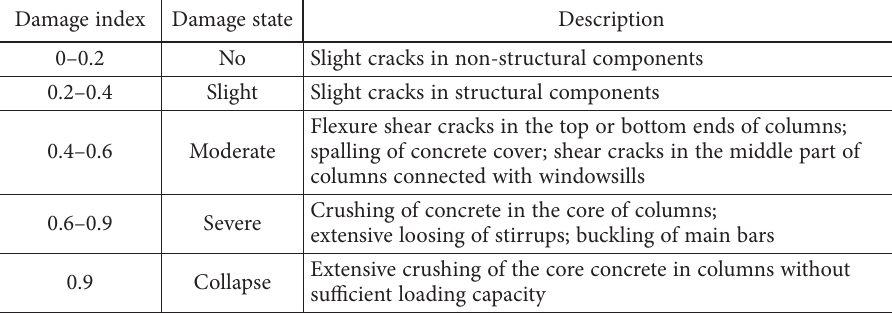
Table 1. Seismic-damage index (source: Chiu & Wang, 2012) Damage